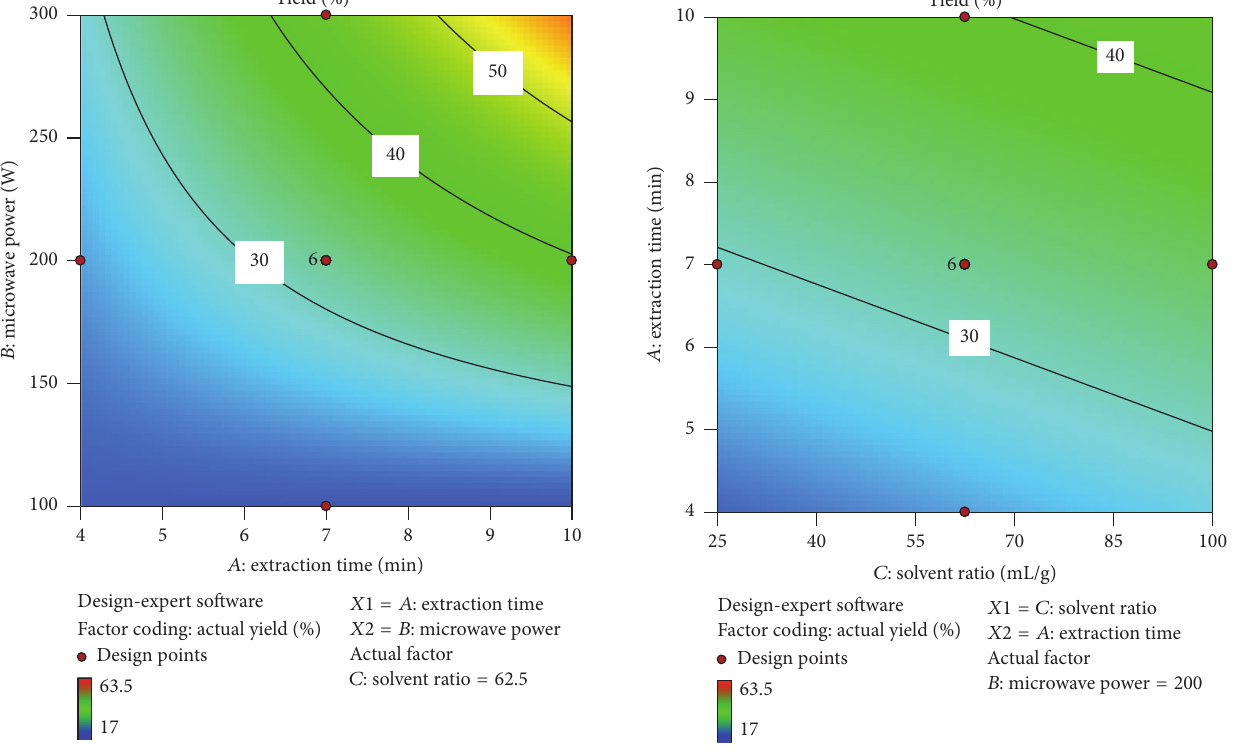
Figure 3: Response surface plot of the interaction between sol- vent/solid ratio ( 𝐶 ) and time ( 𝐴 ) on the extraction yield of roselle